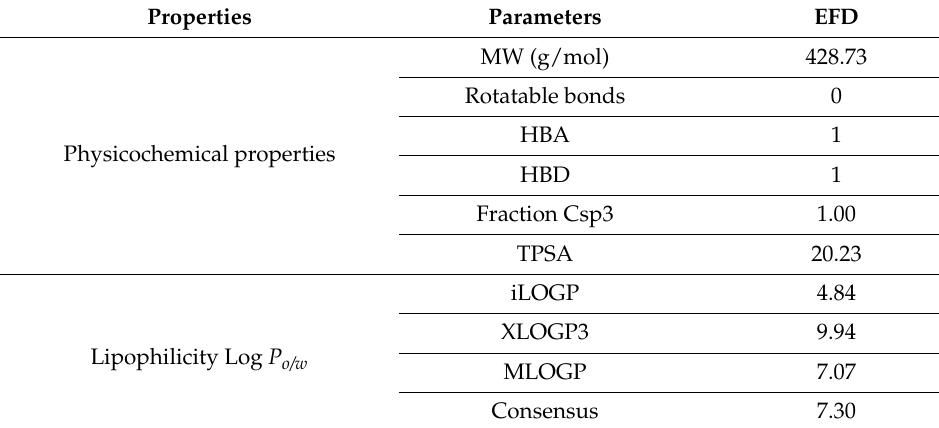
Table 6. EFD’s predicted physicochemical and lipophilic profile.